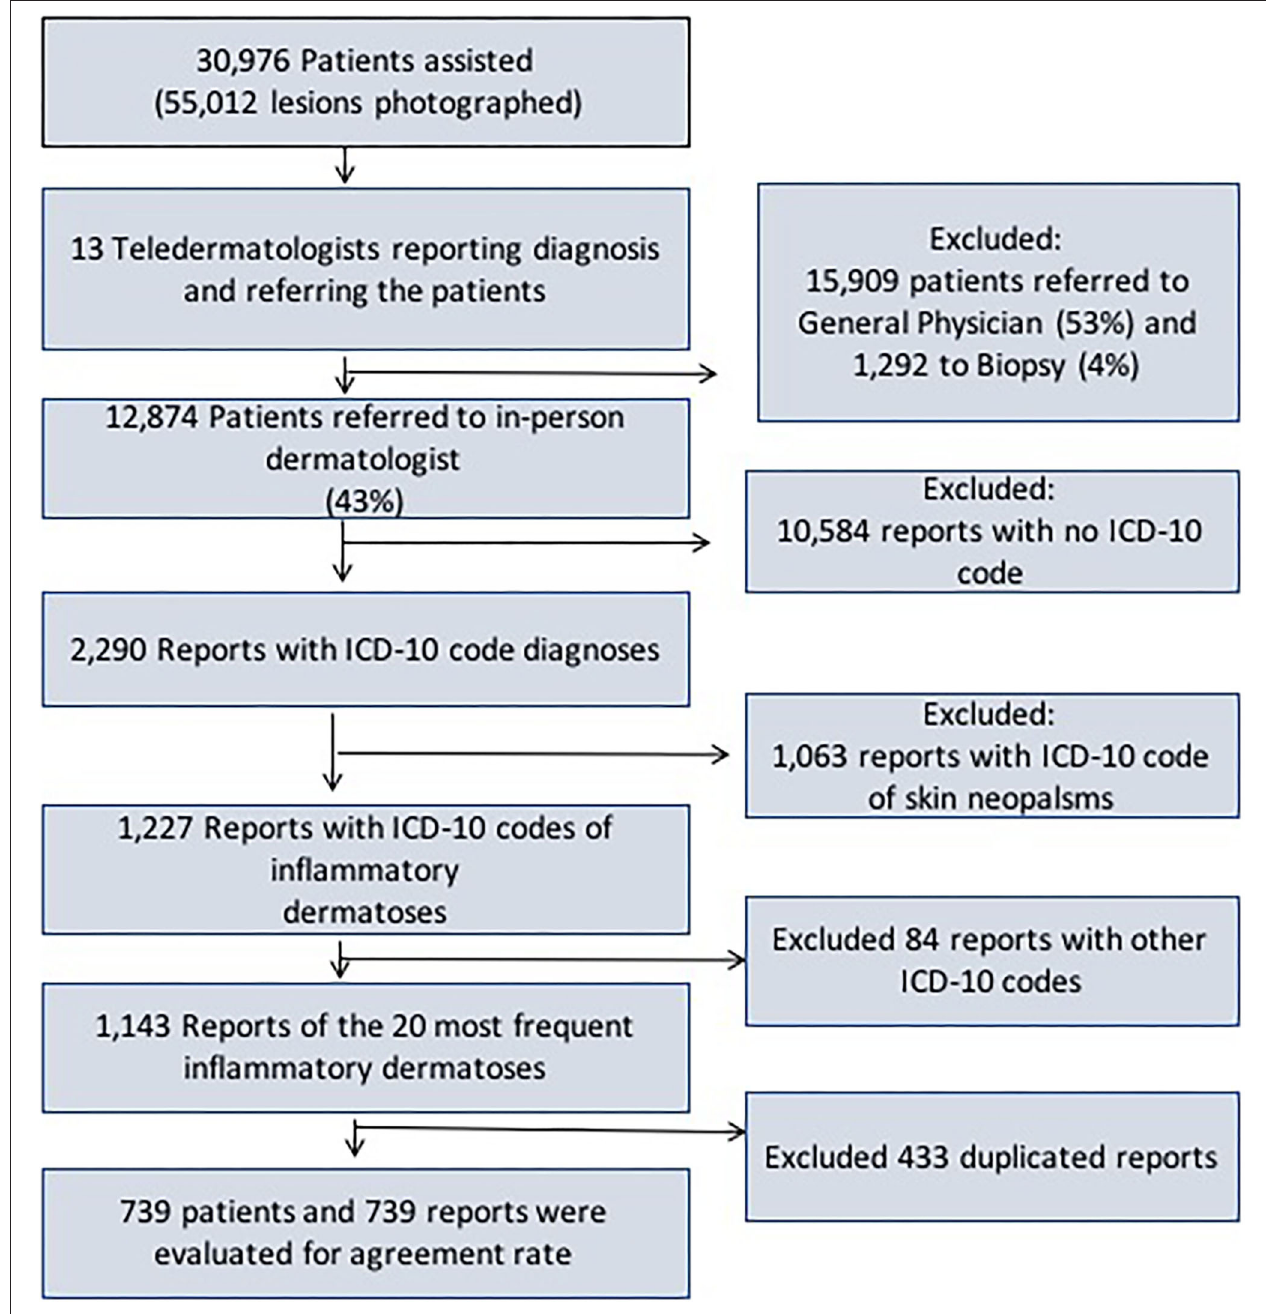
Table 3 assesses the 20 most frequent inflammatory dermatoses diagnosed by in-person dermatologists of which we were able to recover the ICD-10 codes, along with the accuracy of teledermatology found in our study. The mean frequency of complete agreement was 78% for all 20 dermatoses tested (573/739) and its kappa coefficient was 0.743, which is considered